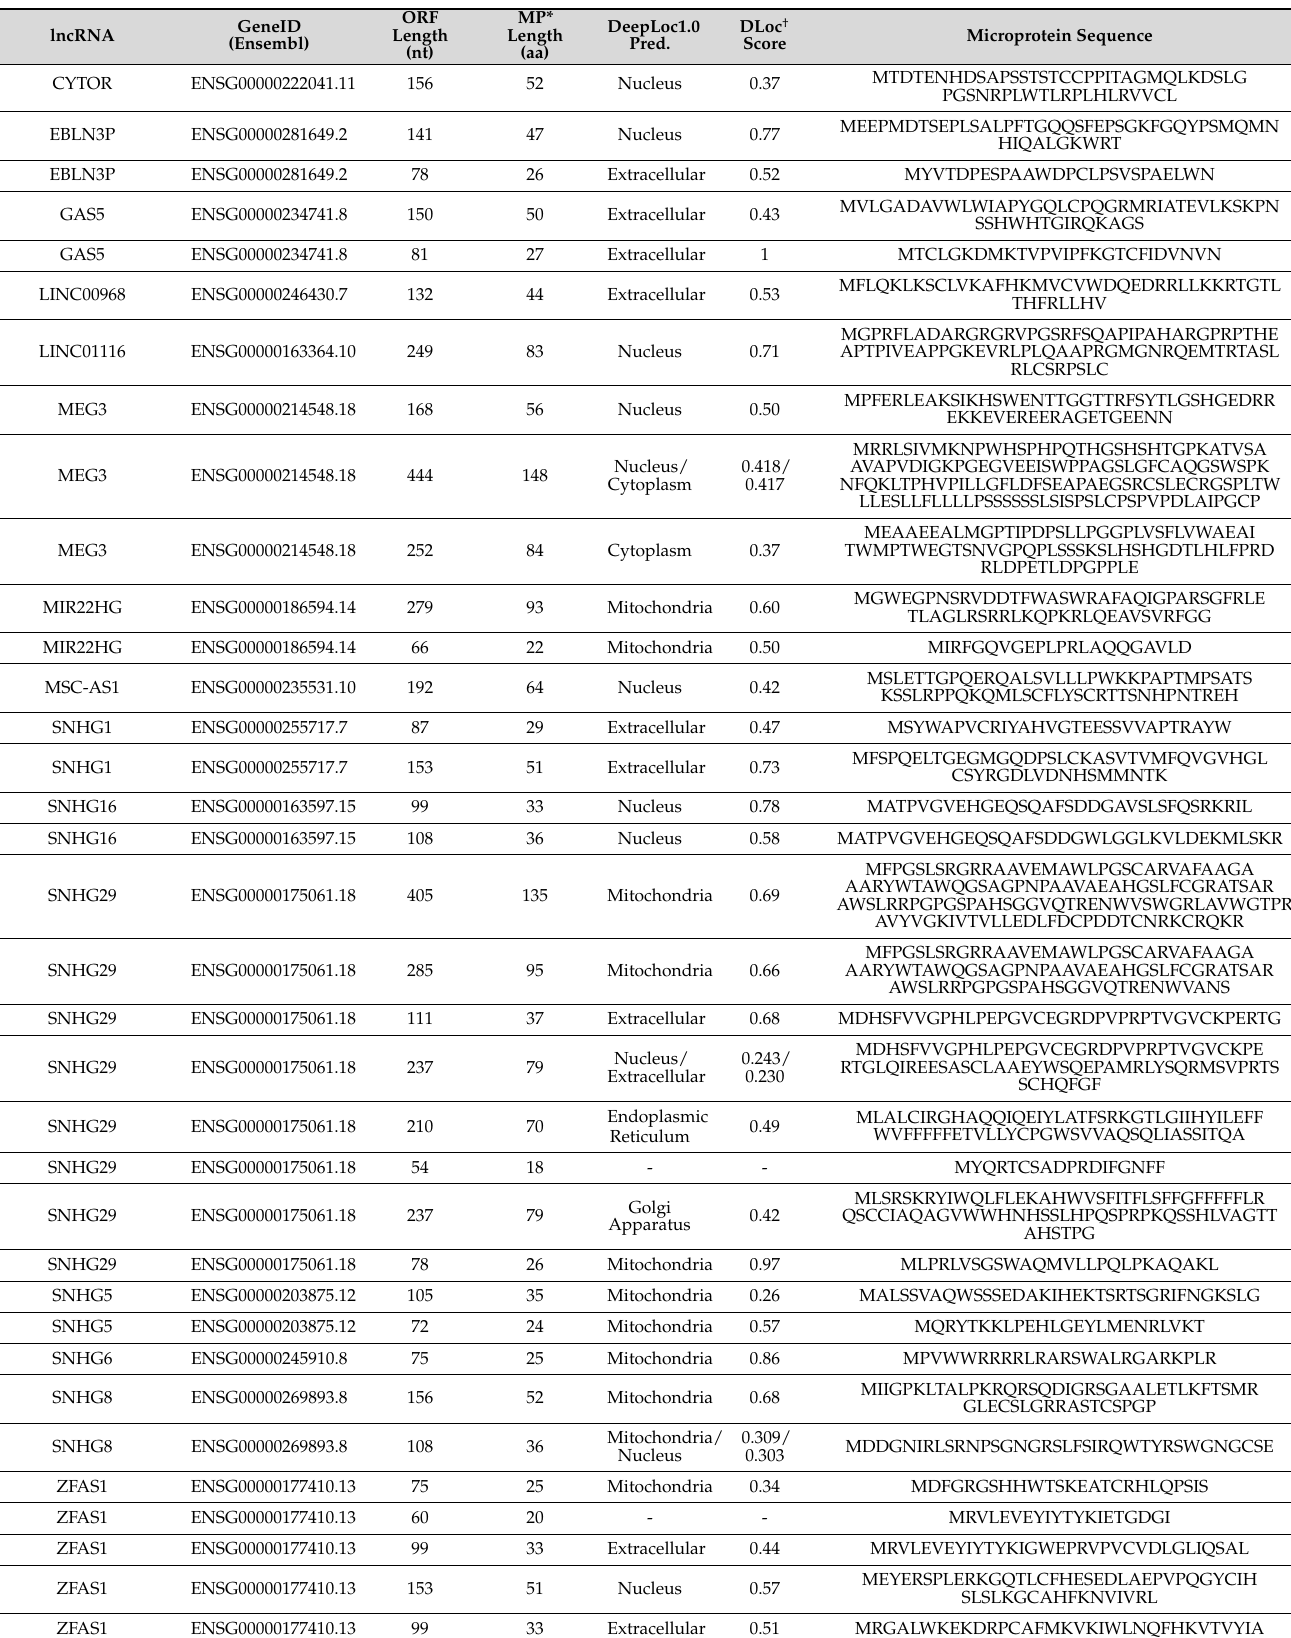
Table 2. Identified smORFs within lncRNAs with ribosome occupancy and their predicted